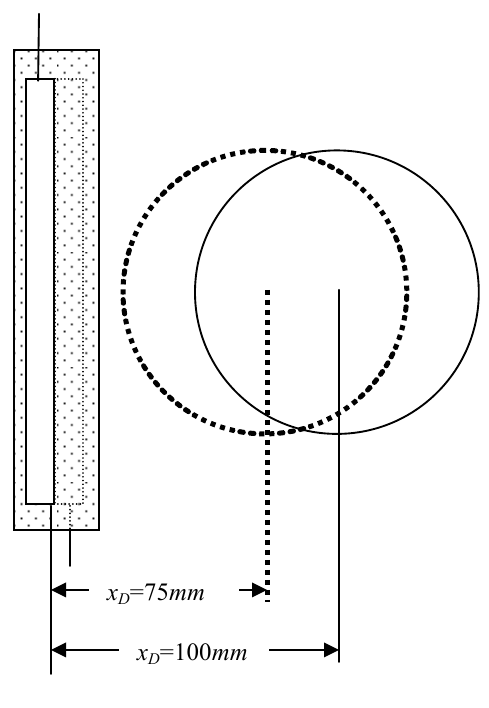
Top view of sensor configuration